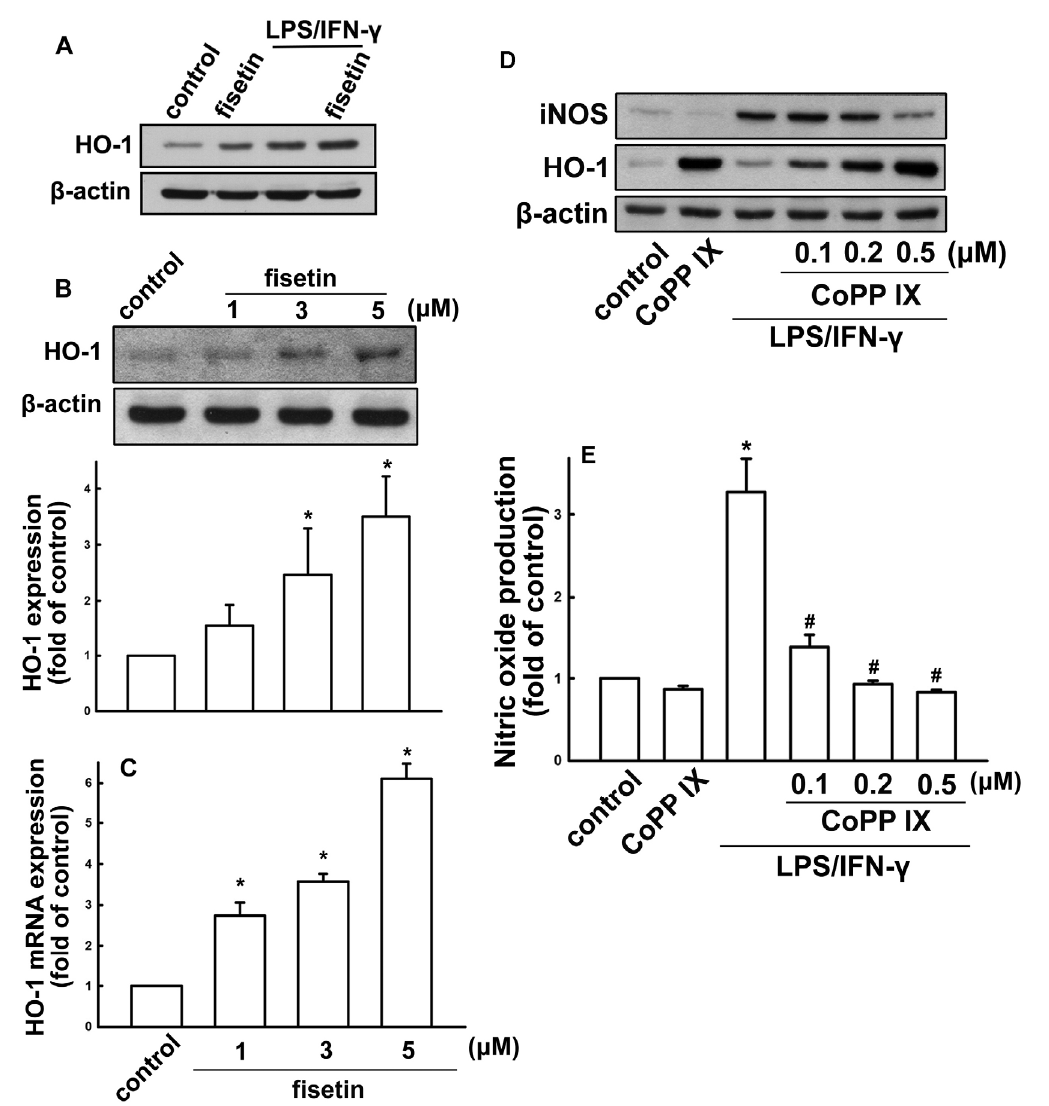
Figure 5. Effect of fisetin on HO-1 expression in microglia cells. ( A ) Cells were treated with fisetin, LPS (10 ng/mL) plus IFN- γ (10 ng/mL), or fisetin with LPS/IFN- γ for 24 h. Cells were treated with different concentrations of fisetin (1, 3, or 5 μ M) for 24 h ( B ) or 6 h ( C ). Whole cell lysates were subjected to western blot analysis for HO-1 protein expression ( A , B ). HO-1 mRNA expressions were analyzed by real time-PCR ( C ). Cells were treated with Copp IX for 60 min, then challenged with LPS plus IFN- γ for another 24 h. The expression of iNOS and HO-1 were determined by western blot analysis ( D ). NO production was analyzed by Griess reaction ( E ). The results are expressed as mean ± S.E.M. from 3 to 4 independent experiments. * p < 0.05 compared with the control group; # p < 0.05 compared with the LPS/IFN- γ treatment alone